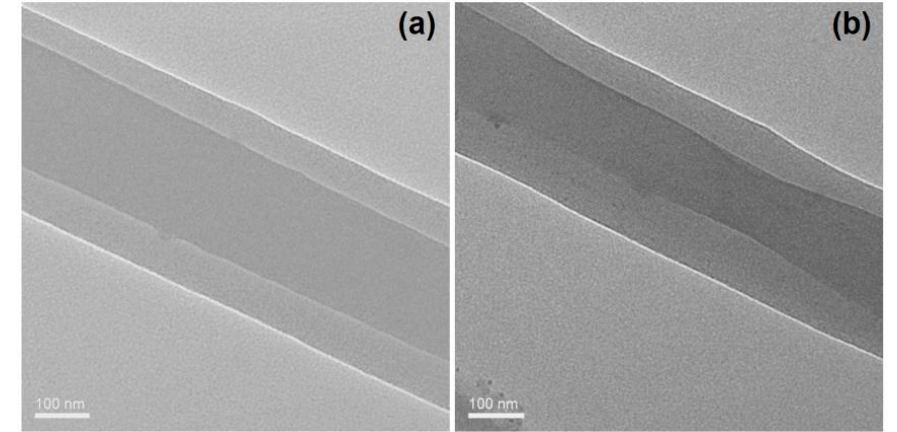
Figure 5. TEM images of the nanofibers: ( a ) nanofibers F1; ( b ) nanofibers F2.